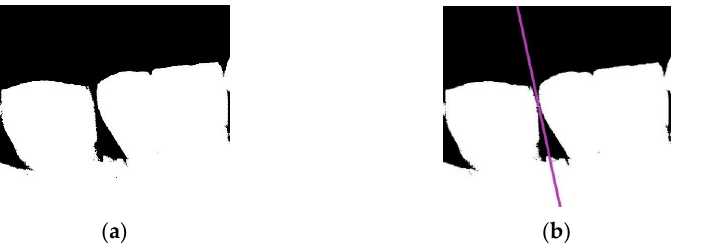
Figure 4. ( a ) The binarized photo showing two teeth; ( b ) precise separating line (purple), deter- mined by rotating the photo and performing vertical